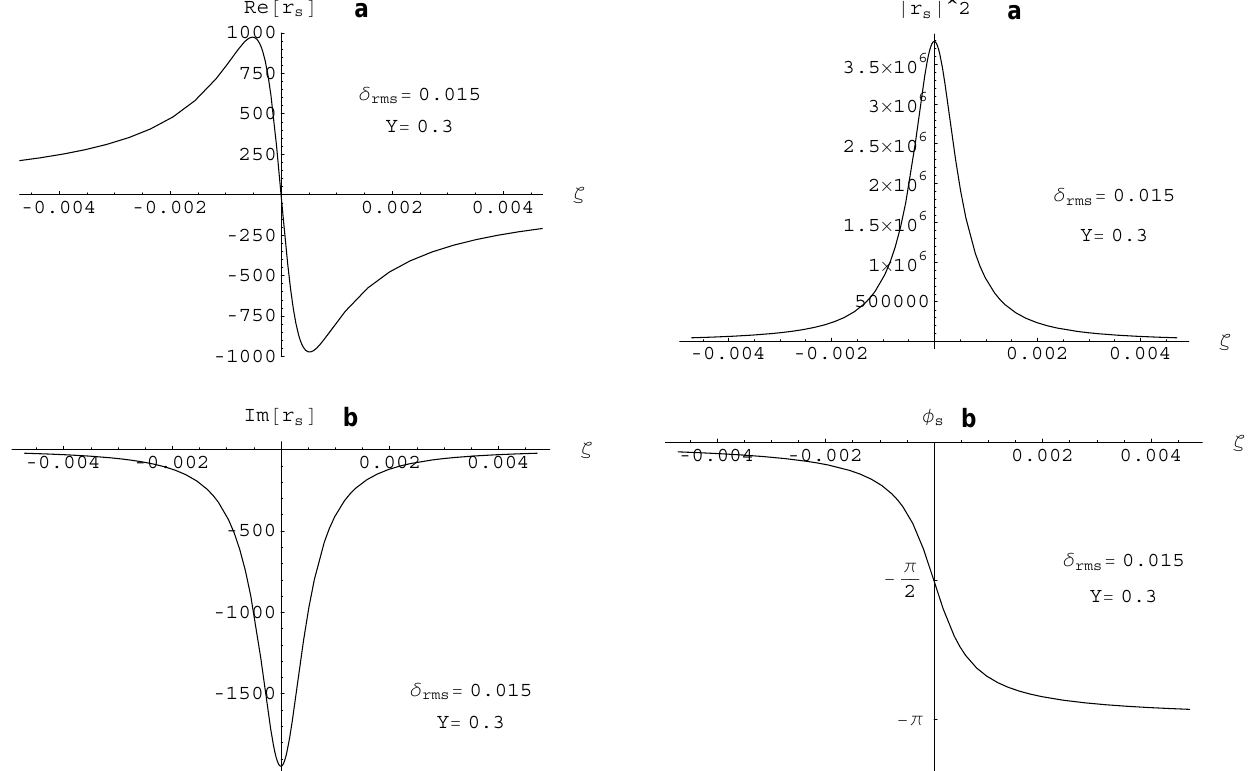
Fig. 3 Fig. 3. The real (a) and imaginary (b) parts of the single scatter resonance function, r s , as a function of coordinate, ζ .